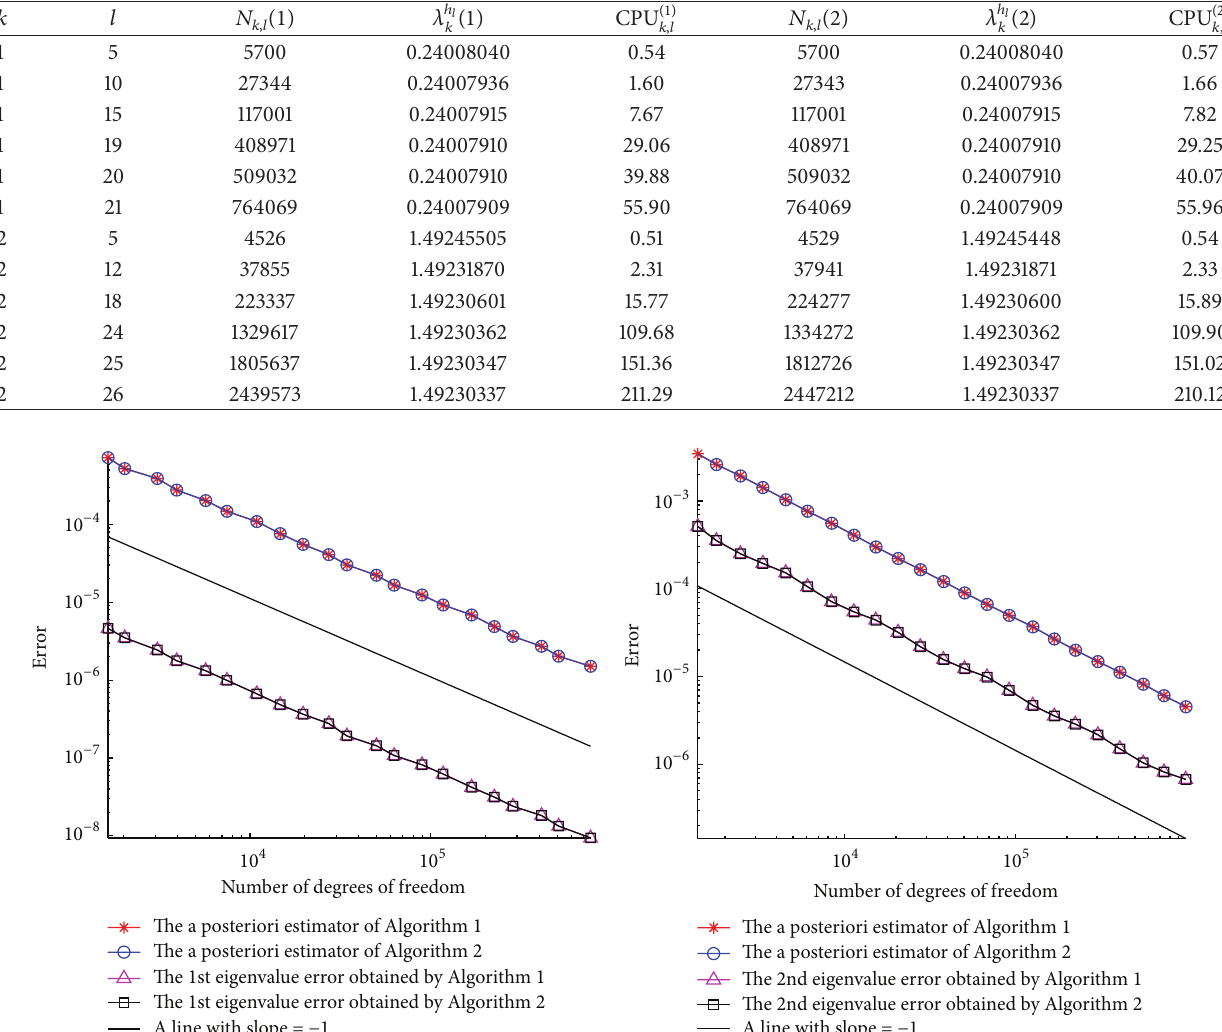
Table 1: The 1st and the 2nd eigenvalues of Example 1 obtained by Algorithms 1 and 2 with 𝐻 = √2/32 .